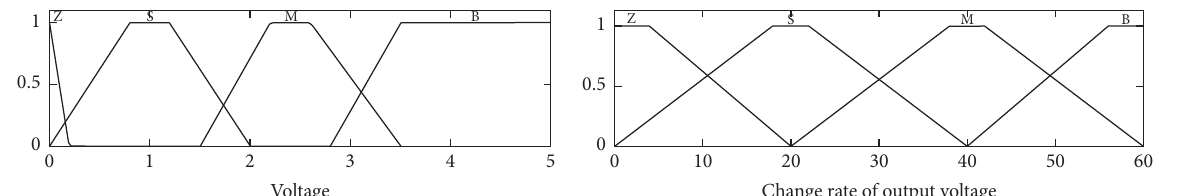
Figure 4: The membership function about output voltage and its change rate.